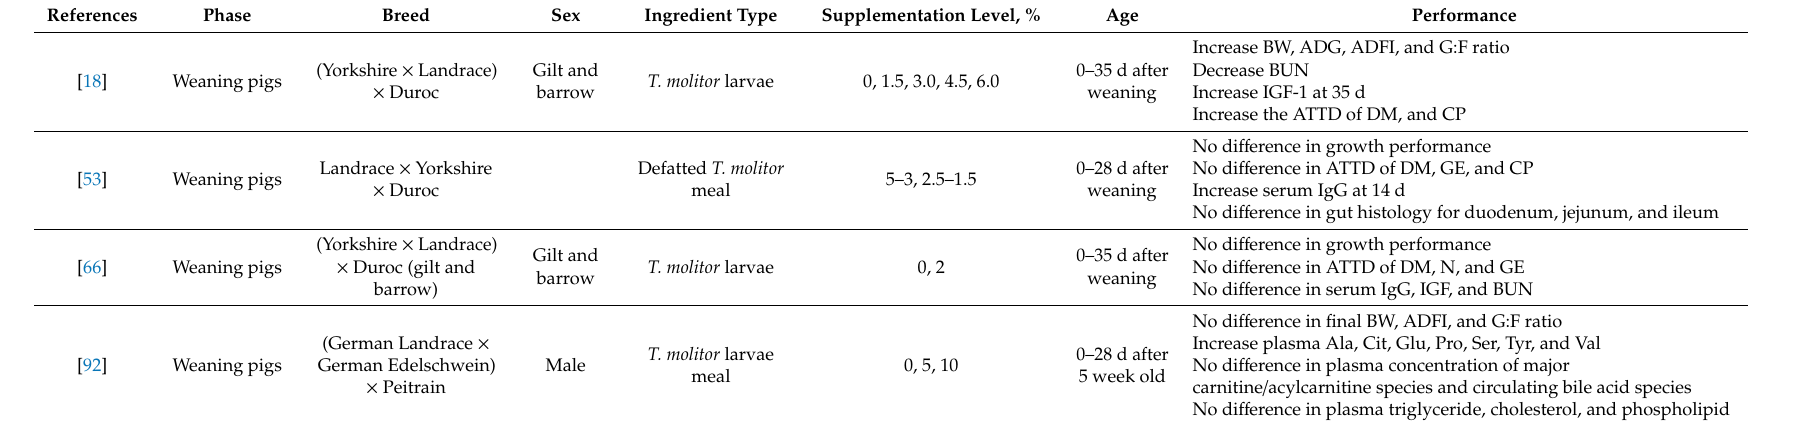
Table 6. E ff ects of Tenebrio molitor larvae or larvae meal supplementation on